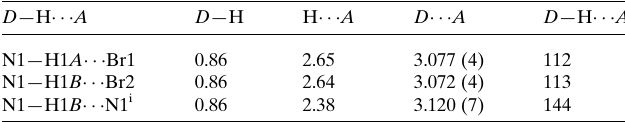
Table 1 Hydrogen-bond geometry (A˚ , (cid:4) ).